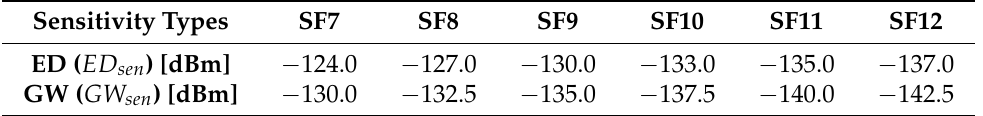
Table 1. ED and GW sensitivities threshold [30,32,33].